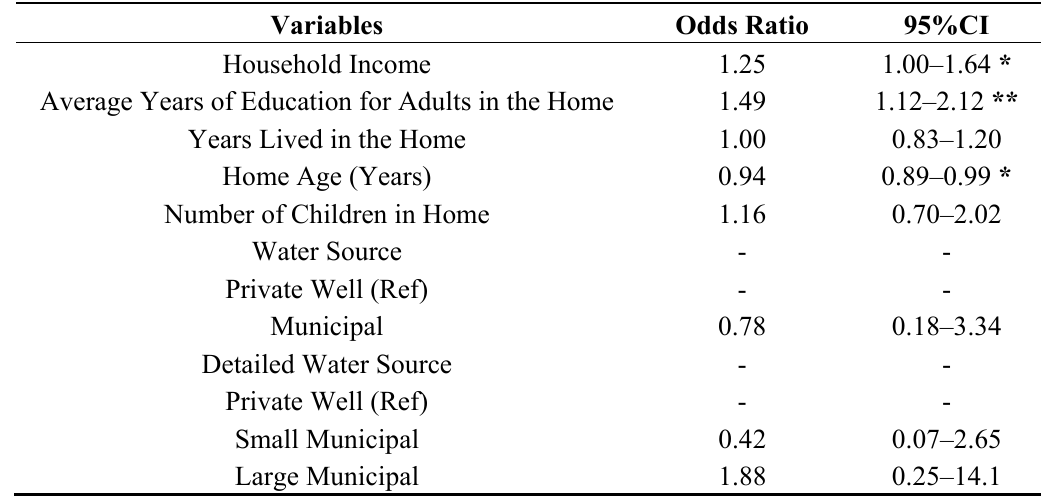
Table 3. Results of simple exact logistic regression analyses assessing tap water treatment (yes or no) according to water source and socio-demographic and home